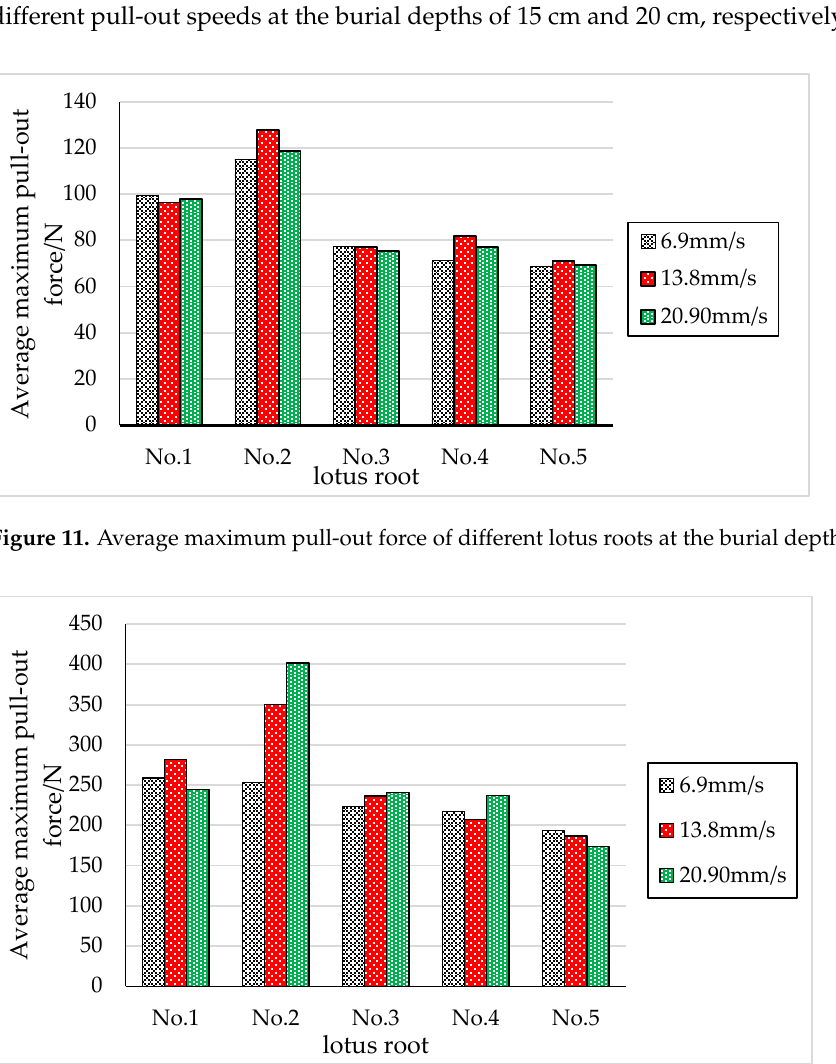
Figure 12. Average maximum pull-out force of different lotus root at the burial depth of 20 cm.